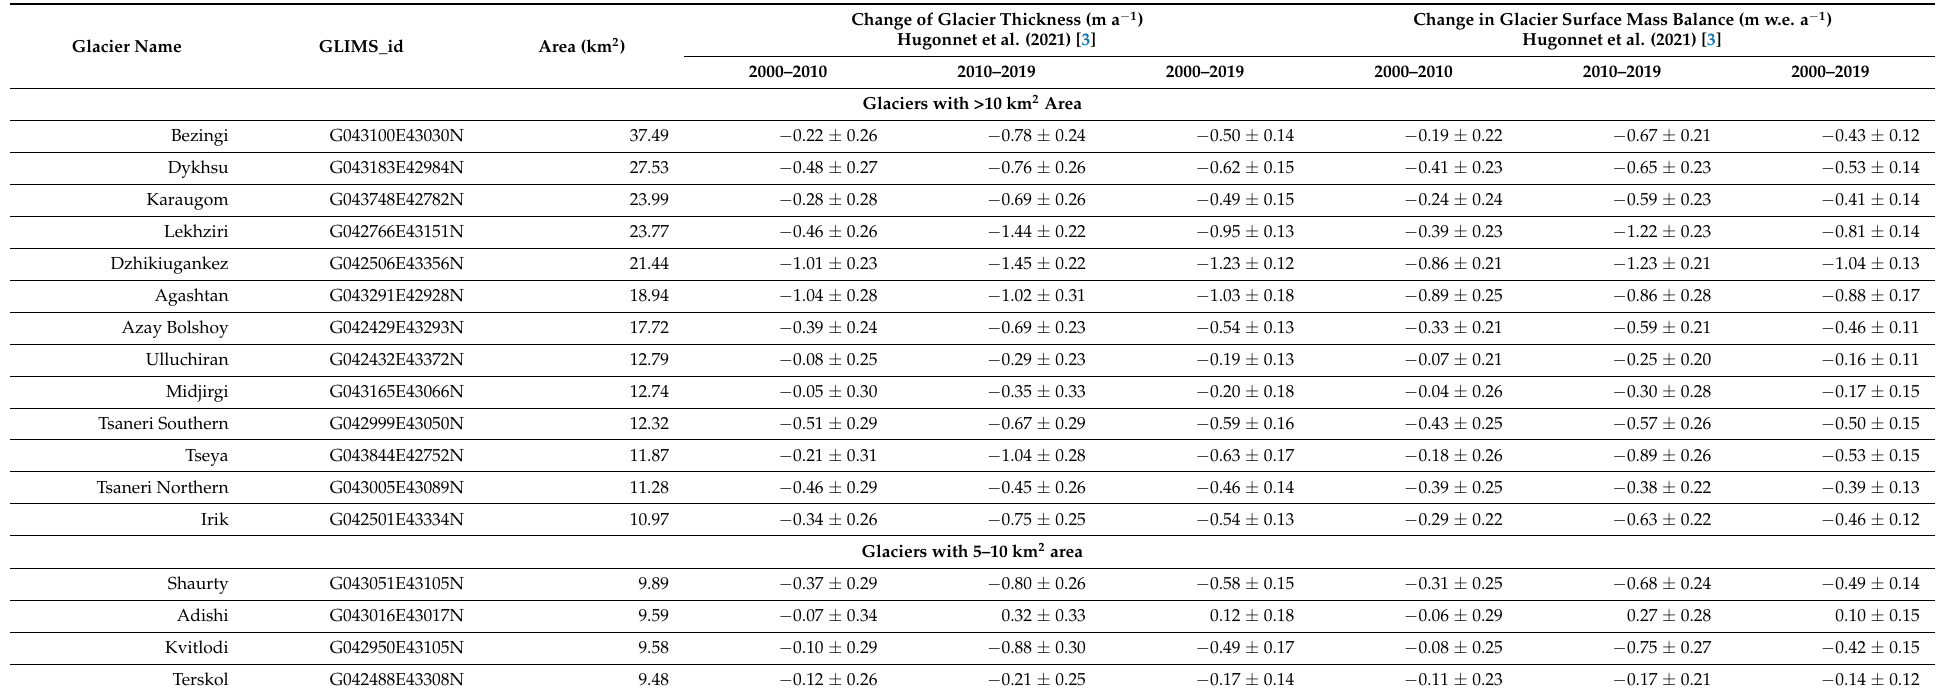
Table A3. Change in glacier thickness (m a − 1 ) and surface mass balance (m w.e. a − 1 ) for individual glaciers > 2.0 km 2 of the Greater Caucasus in